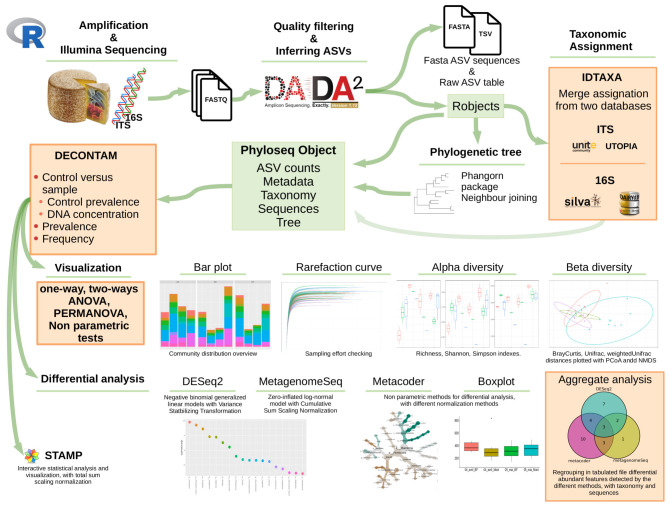
rANOMALY workflow.